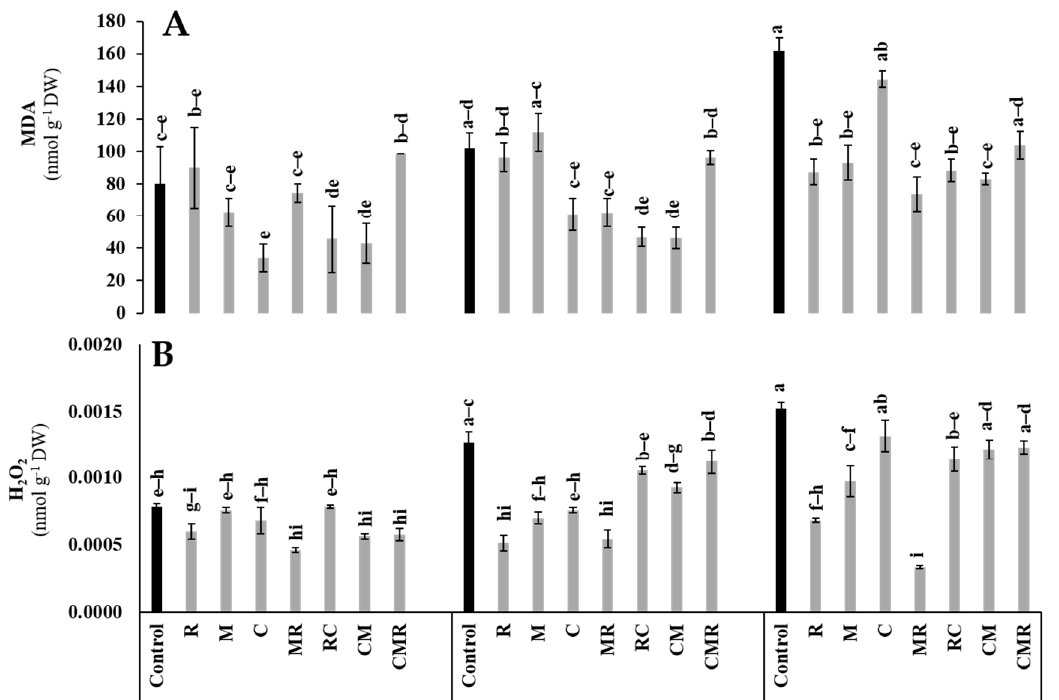
Figure 9. Impact of salt stress (0, 50, and 100 mM NaCl) on ( A ) MDA and ( B ) H 2 O 2 in lettuce subjected to different biostimulant treatments; control plants (non–amended, non–inoculated), and plants inoculated with plant growth promoting rhizobacteria (R) and/or arbuscular mycorrhizal fungi (M), and/or amended with composts (C). Means (±SE of 5 biological replicates) followed by the same letters are not significantly different at p < 0.05 (Tukey’s HSD).